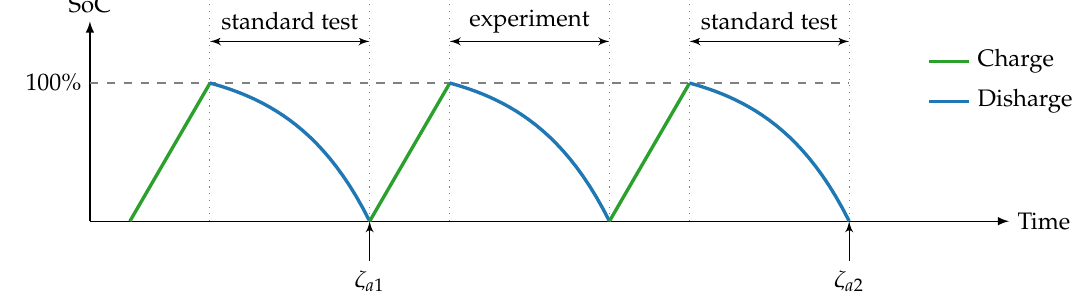
Figure 9. Procedure of finding the aging factor for each specific